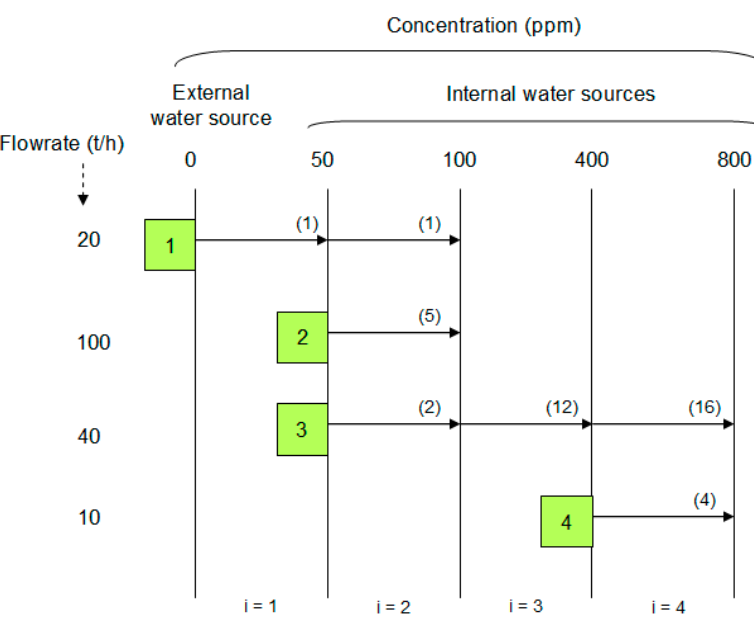
Figure 1. Initial Water Sources Diagram (WSD) representation—example problem.